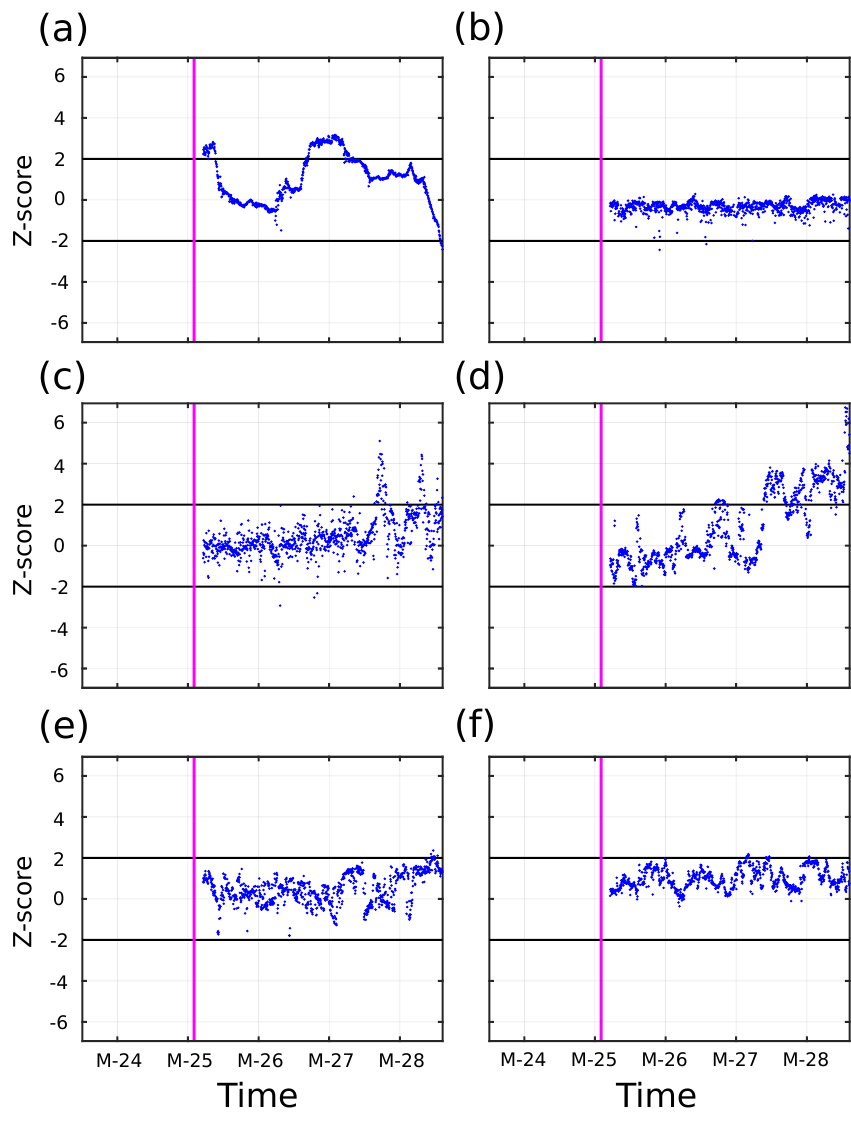
Figure 8. Same as Fig. 6 but for LDC.